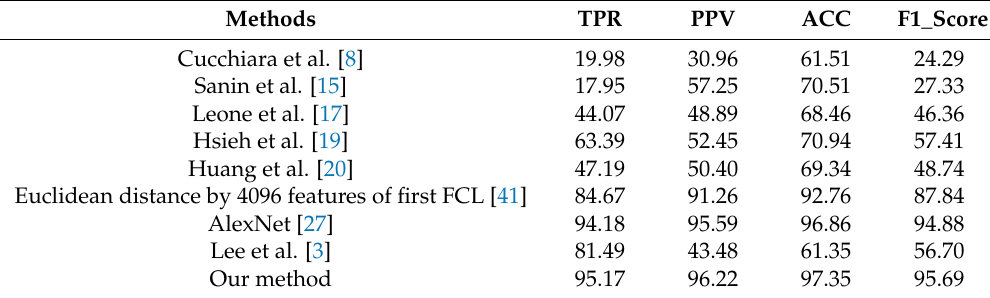
Table 7. Comparisons of accuracy of classification by our method to previous methods (unit: